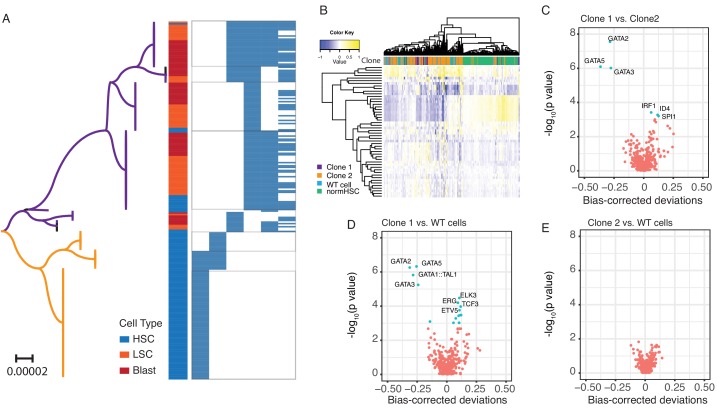
Single cell chromatin accessibility.(A) Phylogenetic relationship of cells from SU353 was inferred using the Neighbor-Joining method. The phylogenetic tree is drawn to scale, with branch lengths in the units of the number of base difference per site. The clade in purple matched to clone 1 and the clade in yellow matched to clone 2 in Figure 2D. The cell type and mtDNA variants in each single cell are shown on the right. 229 single cells with at least one of the six heteroplasmic mtDNA mutations were included. (B) Heat map showing clusters of pHSCs from SU353 and normal HSCs from a healthy donor, based on the z-score of TF deviation. The Z-score deviation is shown for individual cells (columns) for each TF (rows). Clone information is shown on the top of the heat map. Top 50 most variable motifs were used in this heat map. (C) Volcano plot showing the difference in chromatin accessibility for transcription factor binding motifs between Clone 1 and Clone 2. The x-axis shows the mean difference of bias-corrected deviations and the y-axis shows the p-value (in log10 scale). The most significant differential motifs are annotated with TF names. (D) Same as in (C) for Clone 1 vs. WT cells. (E) Same as in (C) for Clone 2 vs. WT cells. No significantly differential motifs were detected.